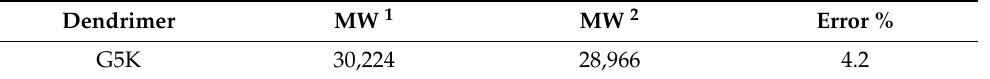
Table 1. Comparison between the MW of G5K estimated by the 1 H NMR spectrum and obtained by volumetric titrations and proper